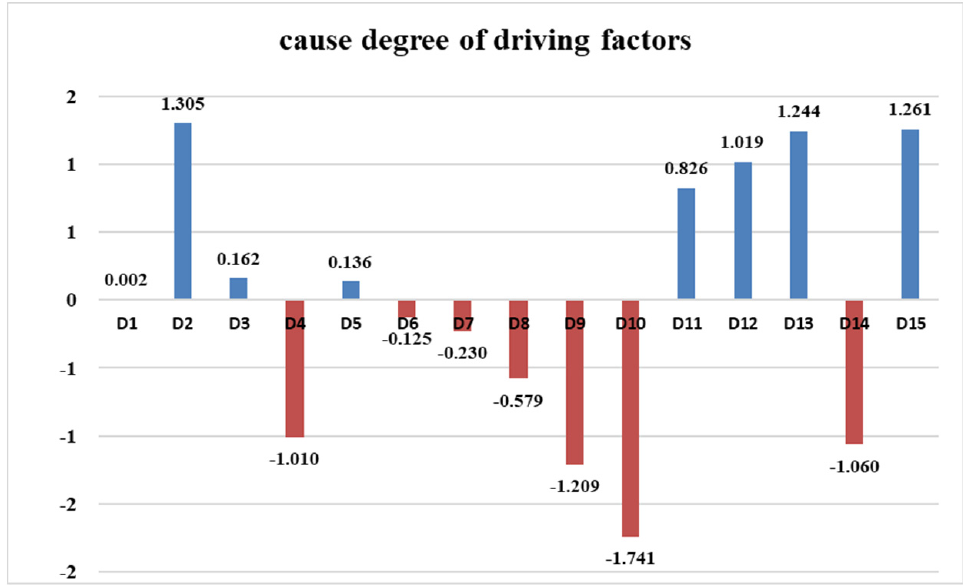
Figure 2. Distribution of cause degree of driving factors.